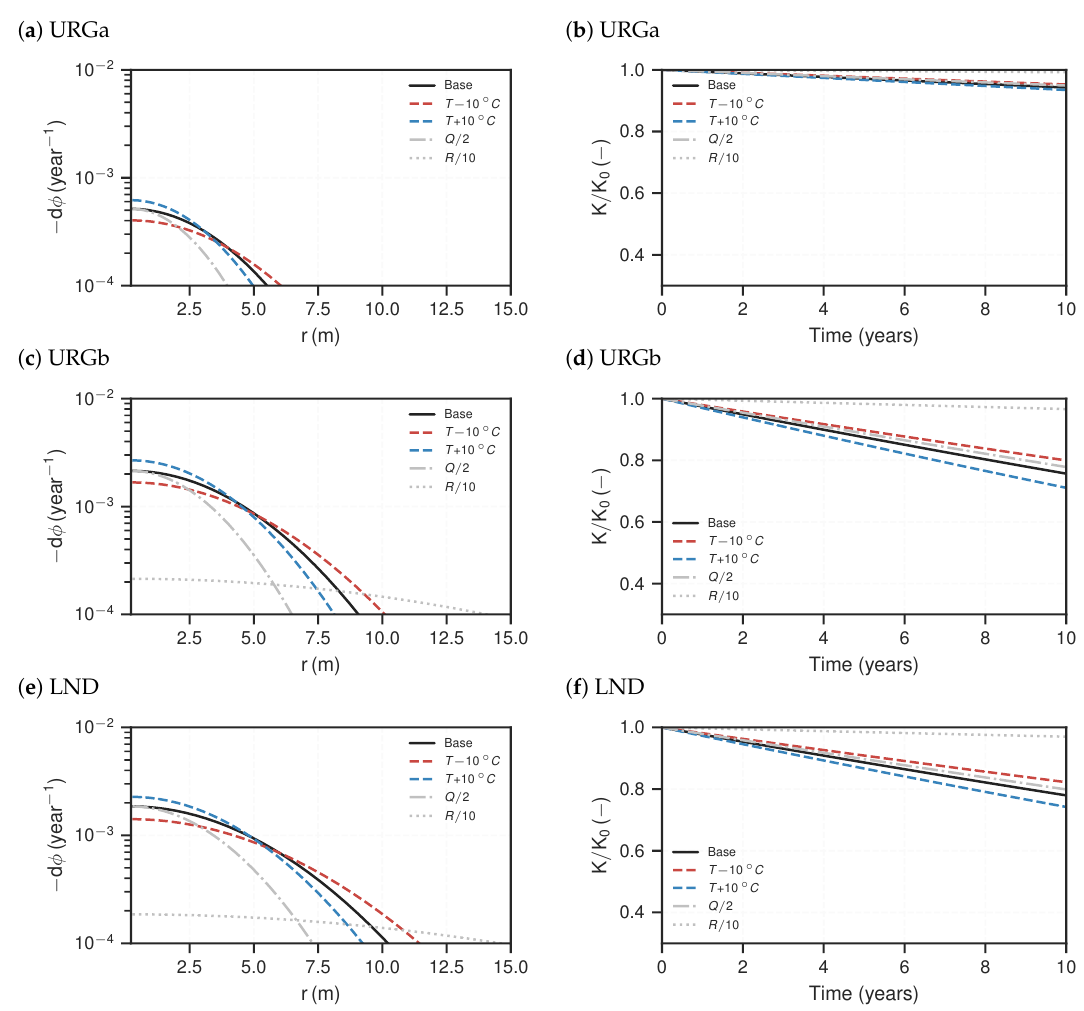
Figure 7. Reactive transport simulation results for the URG cases. ( a , c , e ) Distribution of porosity change per year for steady-state. ( b , d , f ) Resulting relative, effective permeability loss (Equation (14)) based on the porosity–permeability relationship (Equation (13)) over the course of ten years. The lines represent respective scenarios.